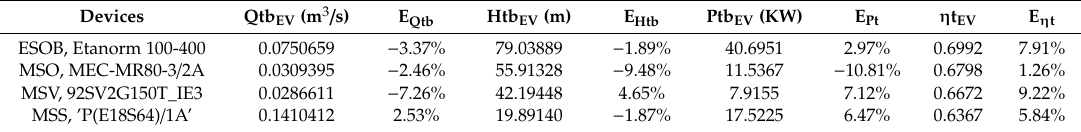
Table 5. PAT performance at BEP, evaluated using the proposed model.